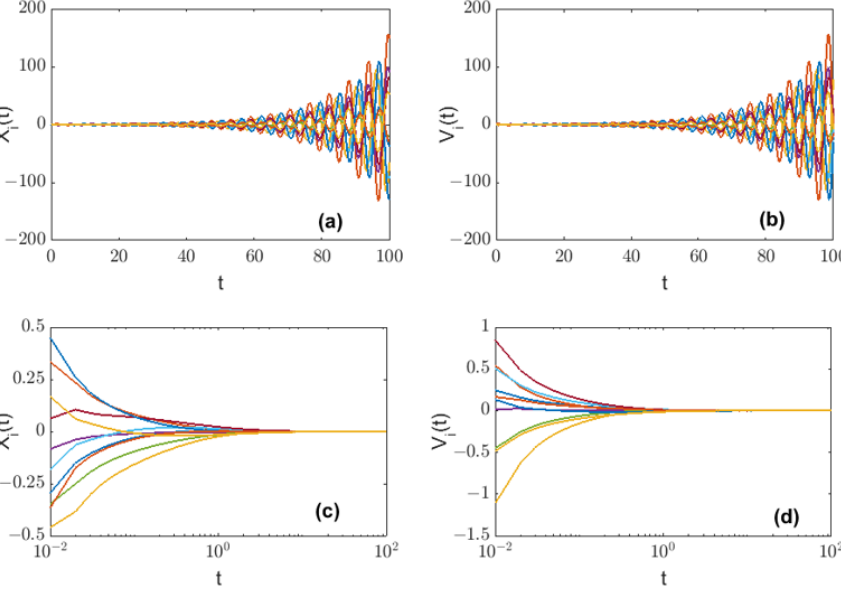
Figure 6. The curves of the position/velocity of each agent as a function of time of FOMAS (3) with